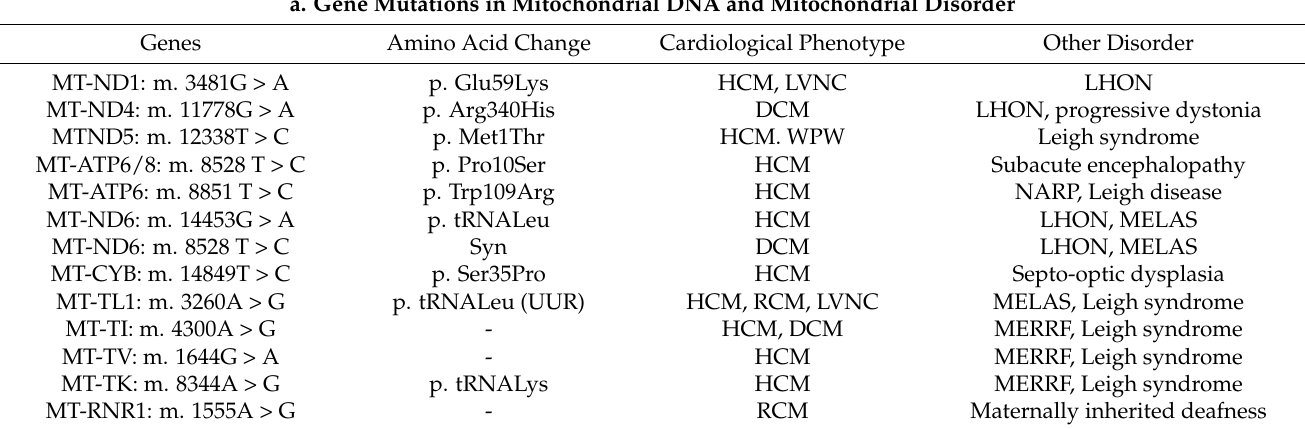
Table 1. List of known causative genes and variants of mitochondrial cardiomyopathy (MCMs). a. Gene Mutations in Mitochondrial DNA and Mitochondrial